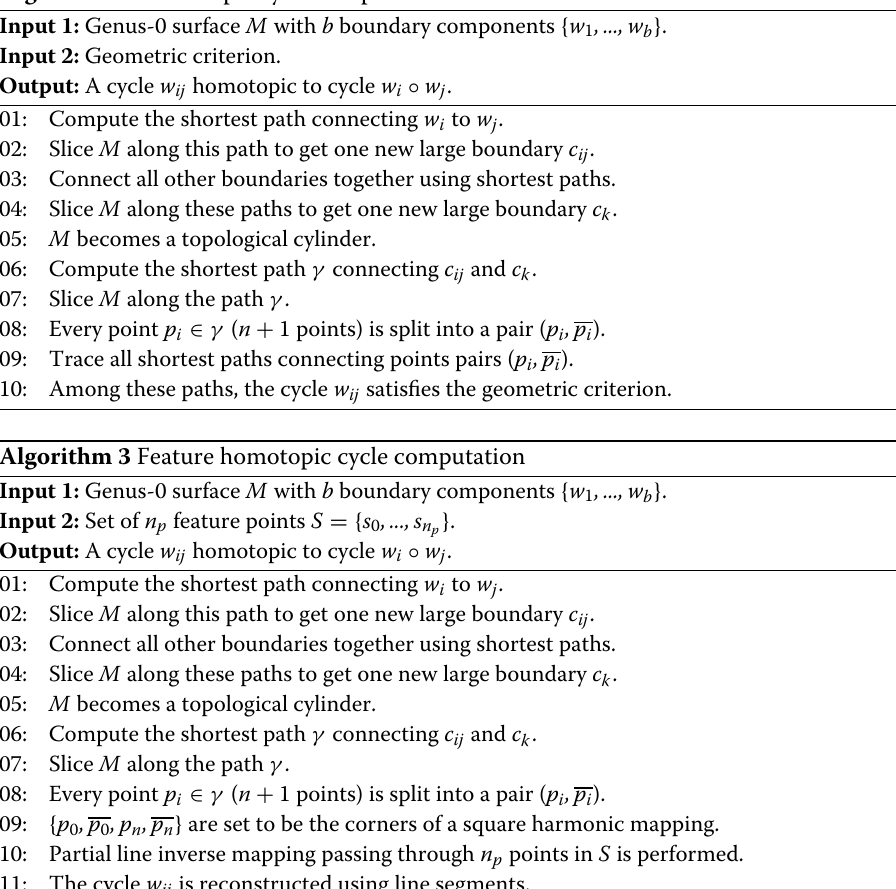
Algorithm 2 Homotopic cycle computation